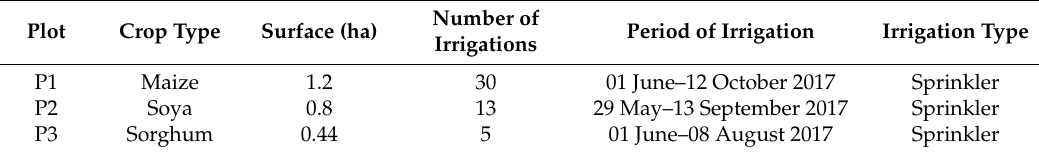
Table 1. Irrigation information over three plots in Montpellier, south-east France.